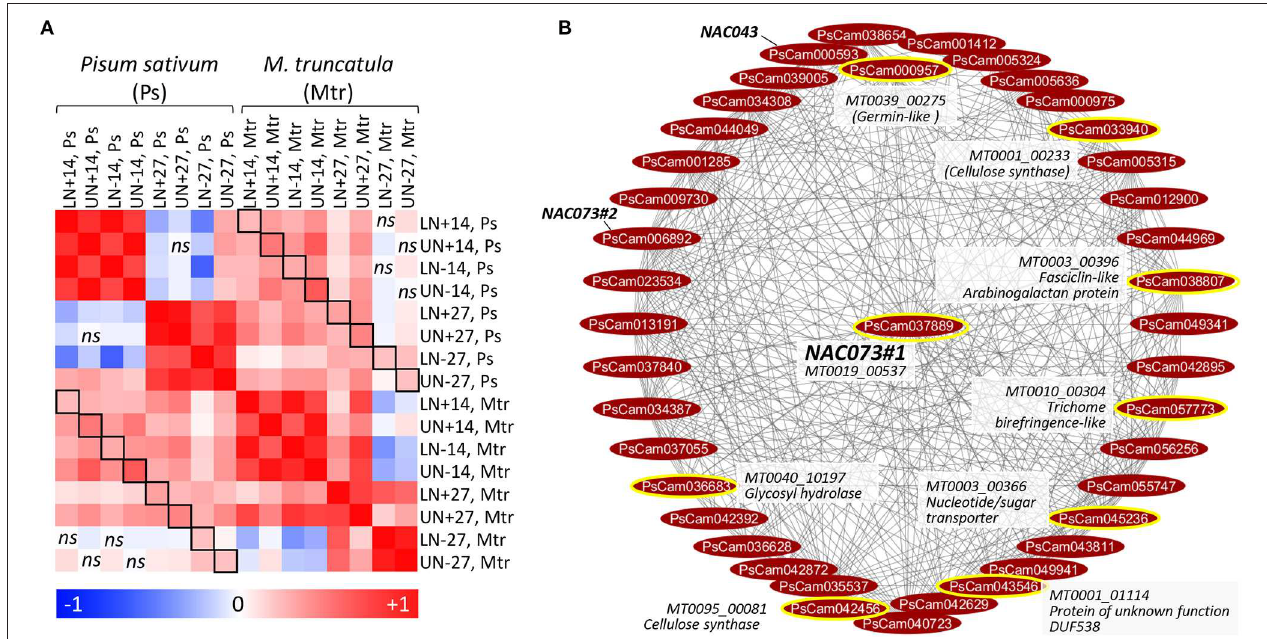
FIGURE 6 | Comparison of leaf transcriptomes and TF-related modules between pea and M. truncatula. (A) Pair-wise Pearson correlation coefficients calculated from each sample comparison expressed in log 2 ratio: beginning of flowering vs. 14 DAF (14), 14 vs. 27 DAF (27), for lower (L), and upper (U) leaves, with nitrogen (N + ), or without nitrogen (N–). The color scale indicates the degree of correlations between transcriptomes. All correlations were significant ( P < 0.05, n = 14980 sequences) except sample comparisons indicated by ns (non-significant). Squares indicate the same samples compared between the two species. (B) NAC073#1 (PsCam037889)-related network in module M7. The connected genes were organized using the circular layout algorithm from Cytoscape. Orthologous genes connected to the NAC073#1 ortholog (MT0019_00537) in M. truncatula (data from Table 2 ) were encircled in yellow and